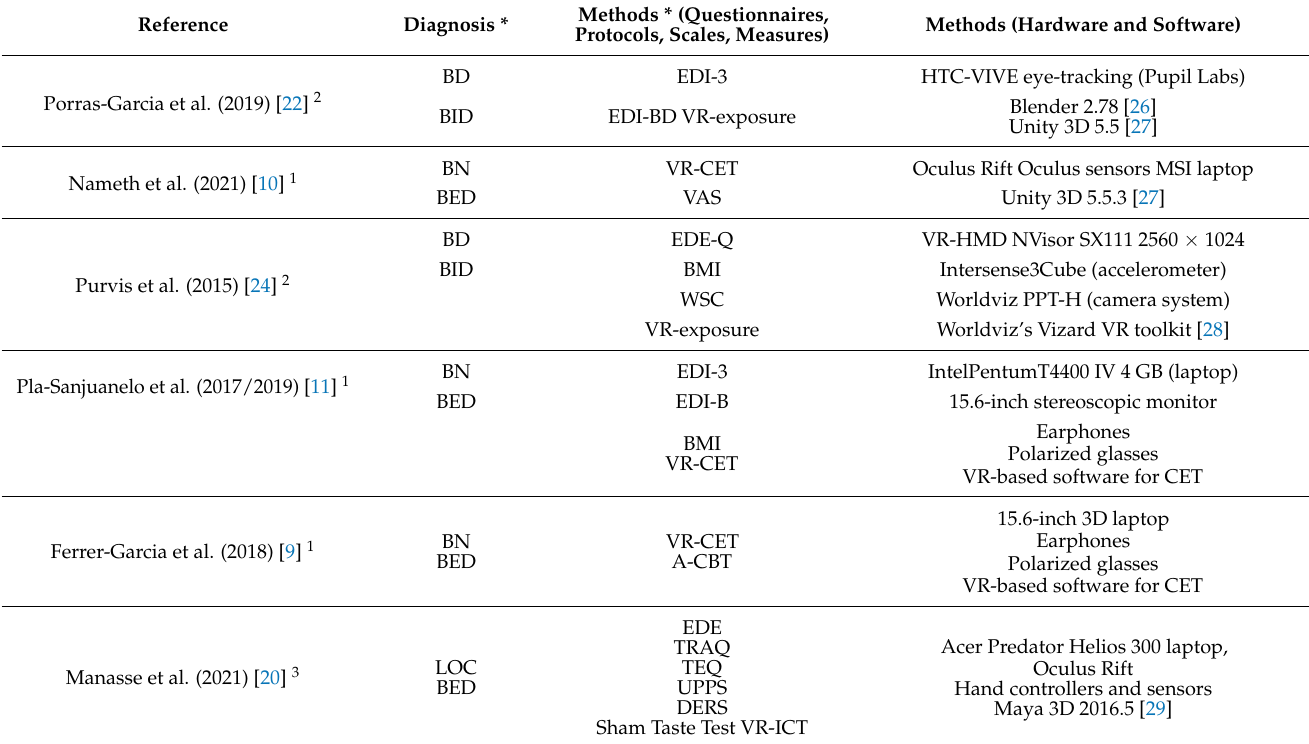
Table 1. The short version of the overview table in Supplementary S2, with details of all publications selected for this